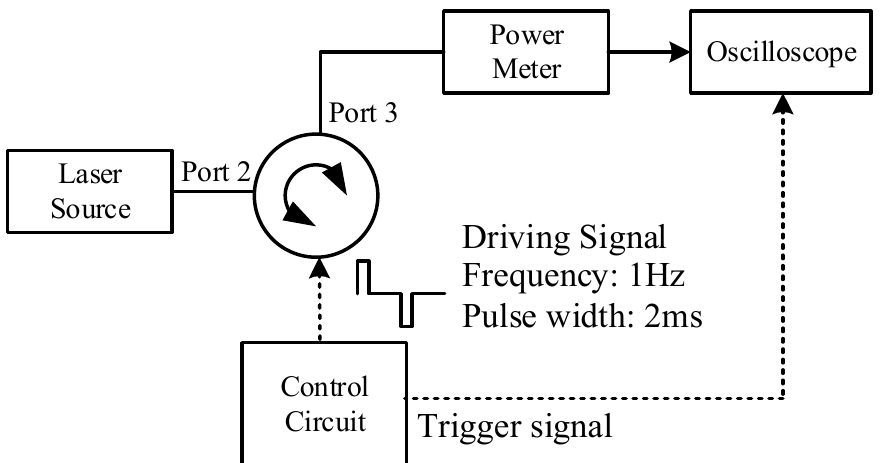
Figure 5. Measurement setup for the response time of the self-made four-port reversible optical circulator.